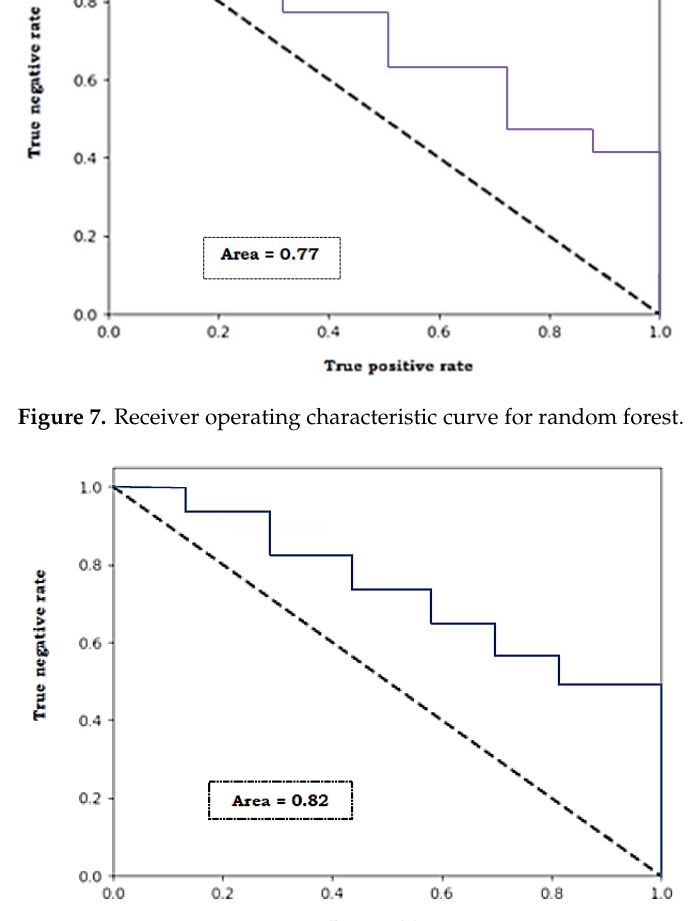
Figure 8. Receiver operating characteristic curve for bagging SVM (majority voting).